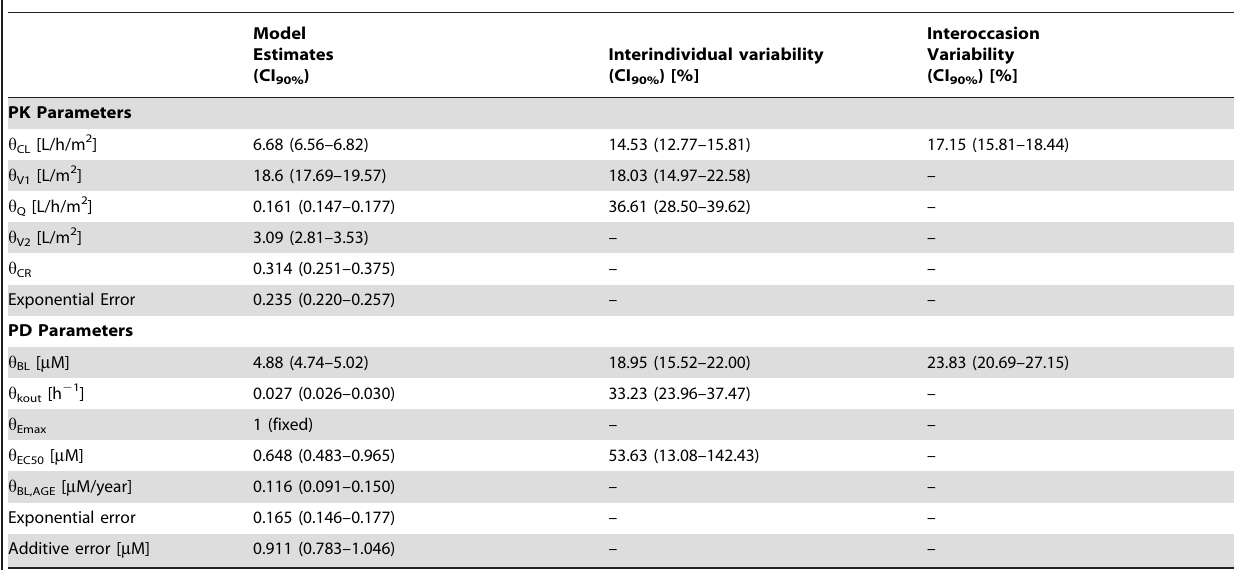
Table 2. Pharmacokinetic and pharmacodynamic model